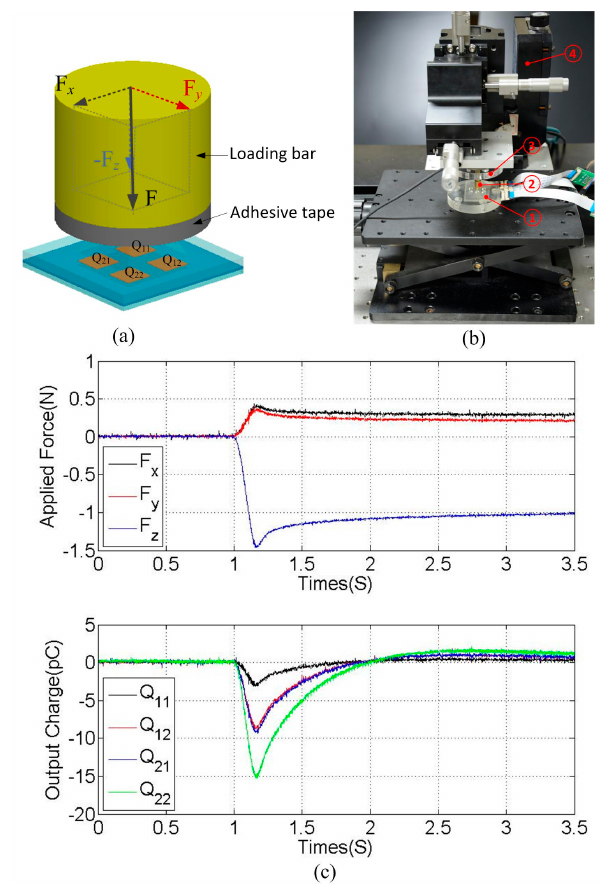
Figure 9. ( a ) Illustration of applying three-axis force on each unit of the sensor array; ( b ) photograph of the force loading system ( ○ 1 the fabricated tactile sensor array, ○ 2 the brass loading bar, ○ 3 the six-axis load cell, ○ 4 three-axial motion platform); and ( c ) response of a tactile unit to a three-axis force.